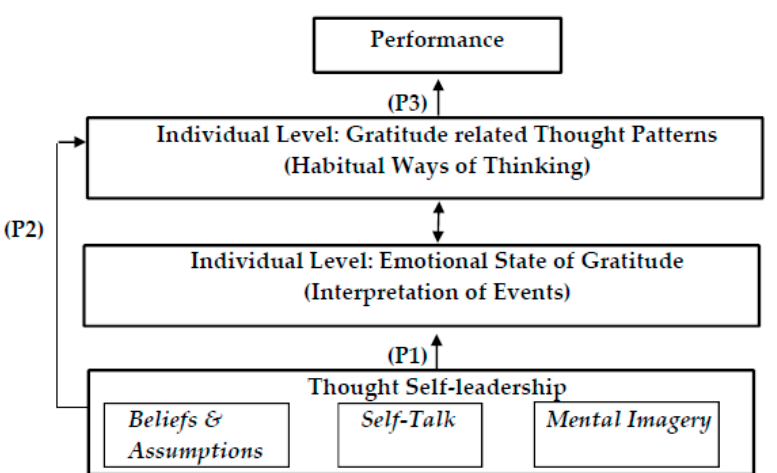
Figure 1. A conceptual model of thought self-leadership (TSL)’s impact on